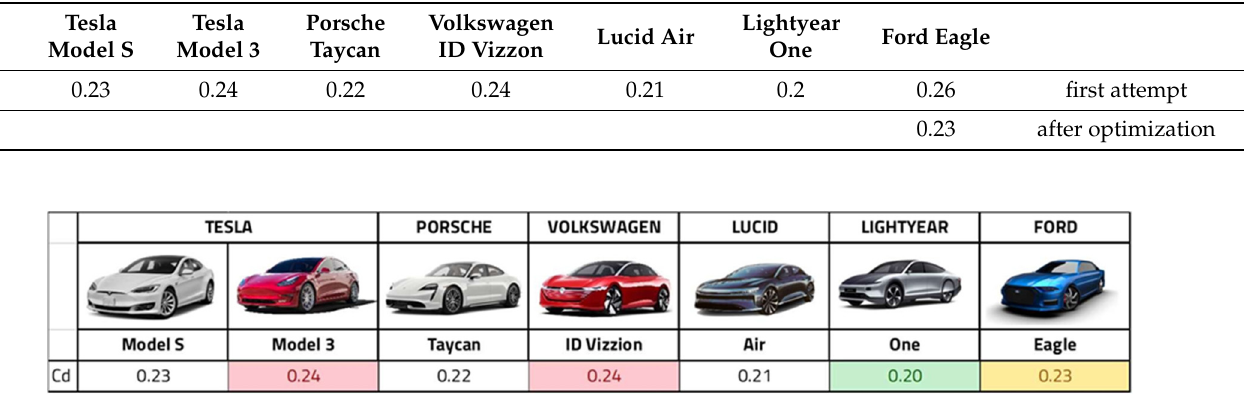
Figure 15. Comparison of Cd values after optimization phase.